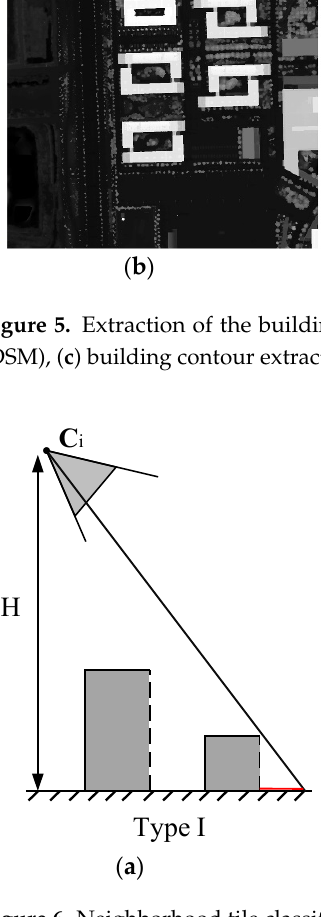
Figure 6. Neighborhood tile classification. ( a ) Type I, ( b ) current tile, and ( c ) Type